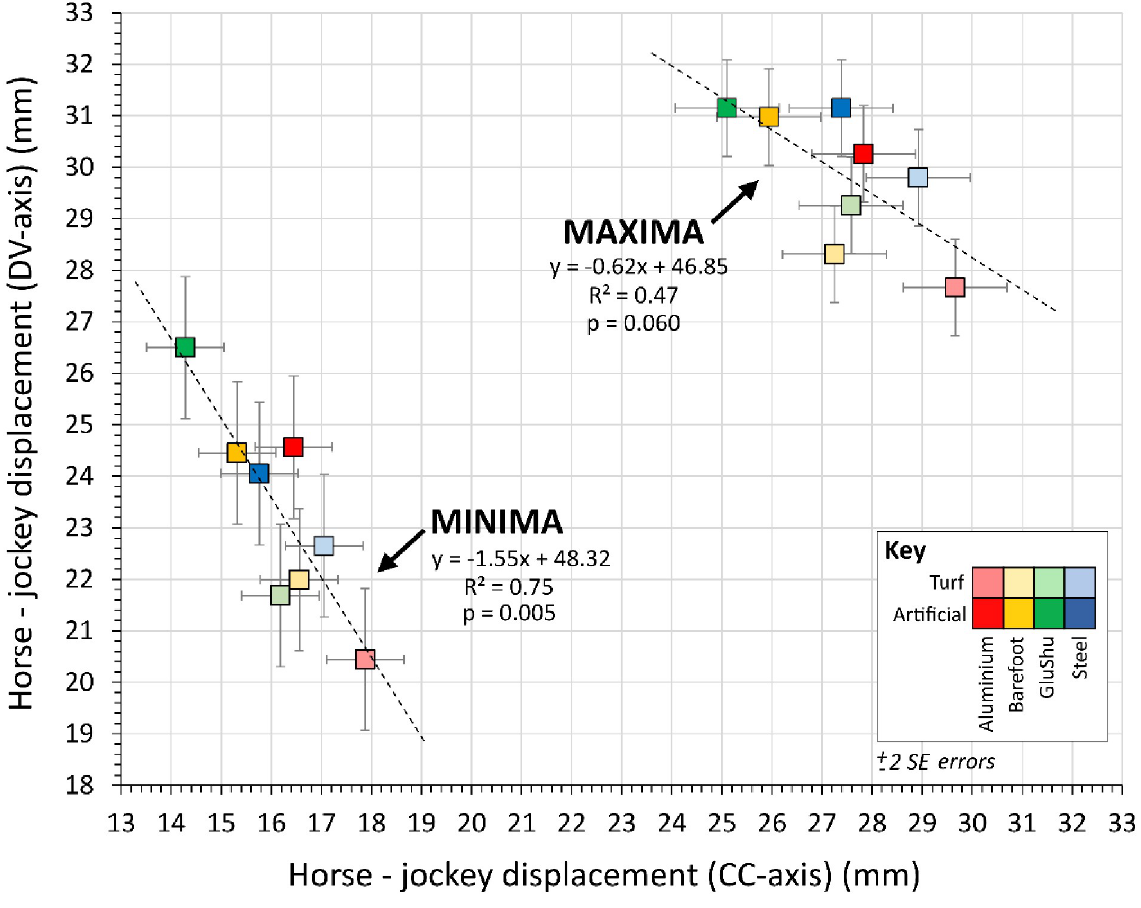
Fig 13. Relationship between cranio-caudal (CC) axis and dorso-ventral (DV) axis data for horse-jockey estimated marginal mean (EMM) differences per shoe-surface combination, sub-divided into minima and maxima. Properties of the linear regression lines are indicated. Errors are ± 2